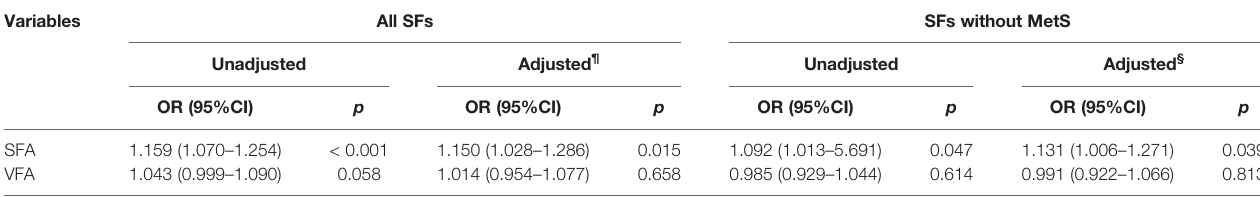
TABLE 2 | The relationship between SFA, VFA, and the occurrence of stone episode.